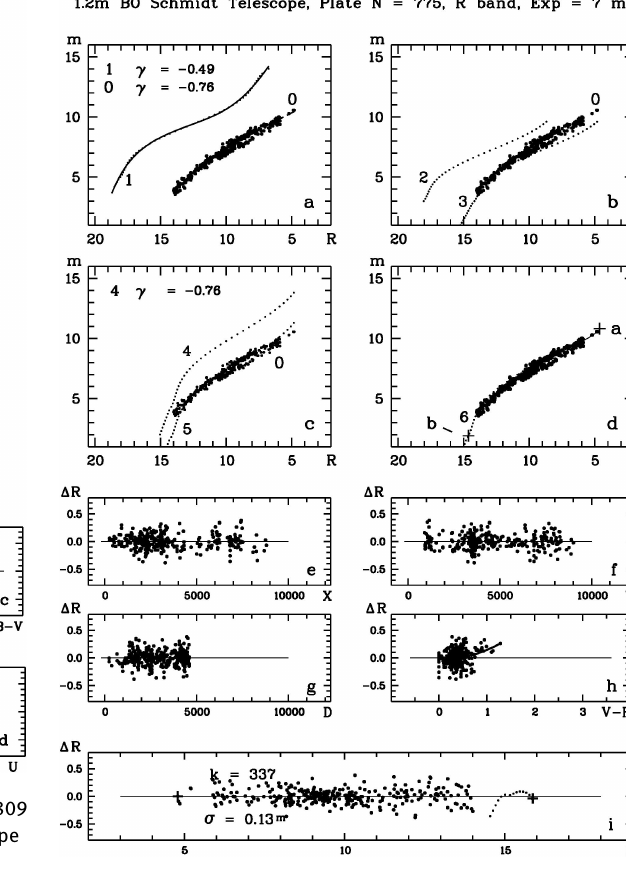
Figure 7. Stages of constructing the characteristic curve for plate No. 775 exposed in the R band at the 1.2 m Baldone Schmidt